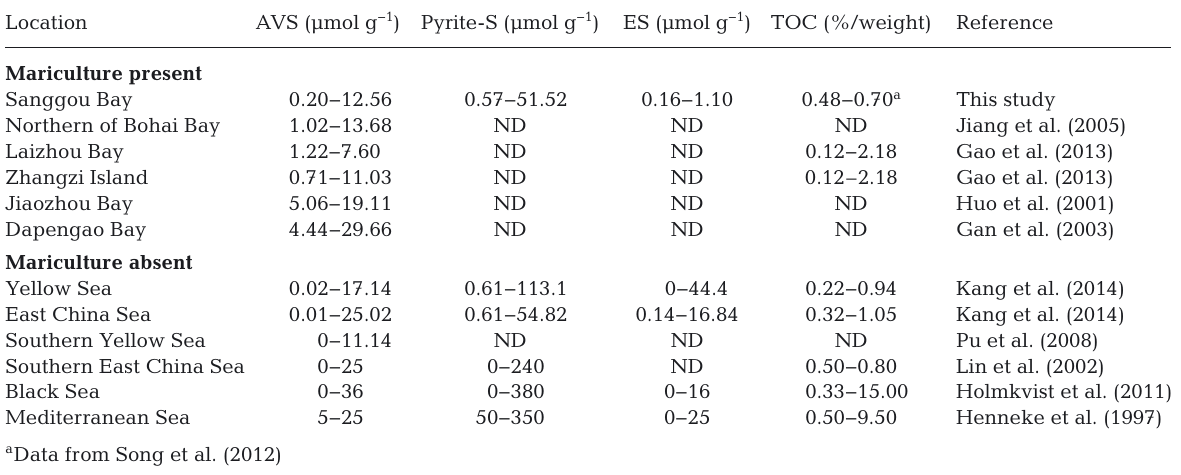
Table 4. Concentrations of various sulfur species in the sediments of Sanggou Bay in comparison to other sea regions. AVS: acid-volatile sulfide, ES: elemental sulfur, TOC: total organic carbon, ND: no